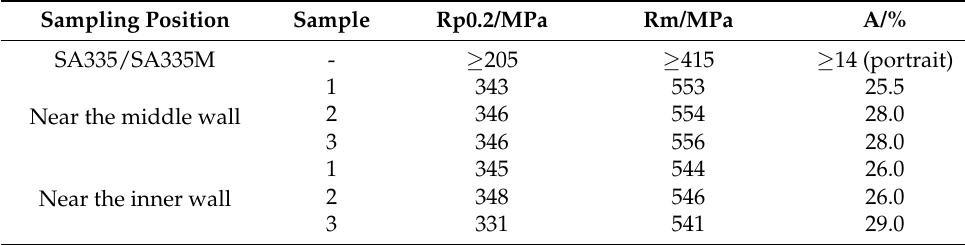
Table 4. The transverse tensile test